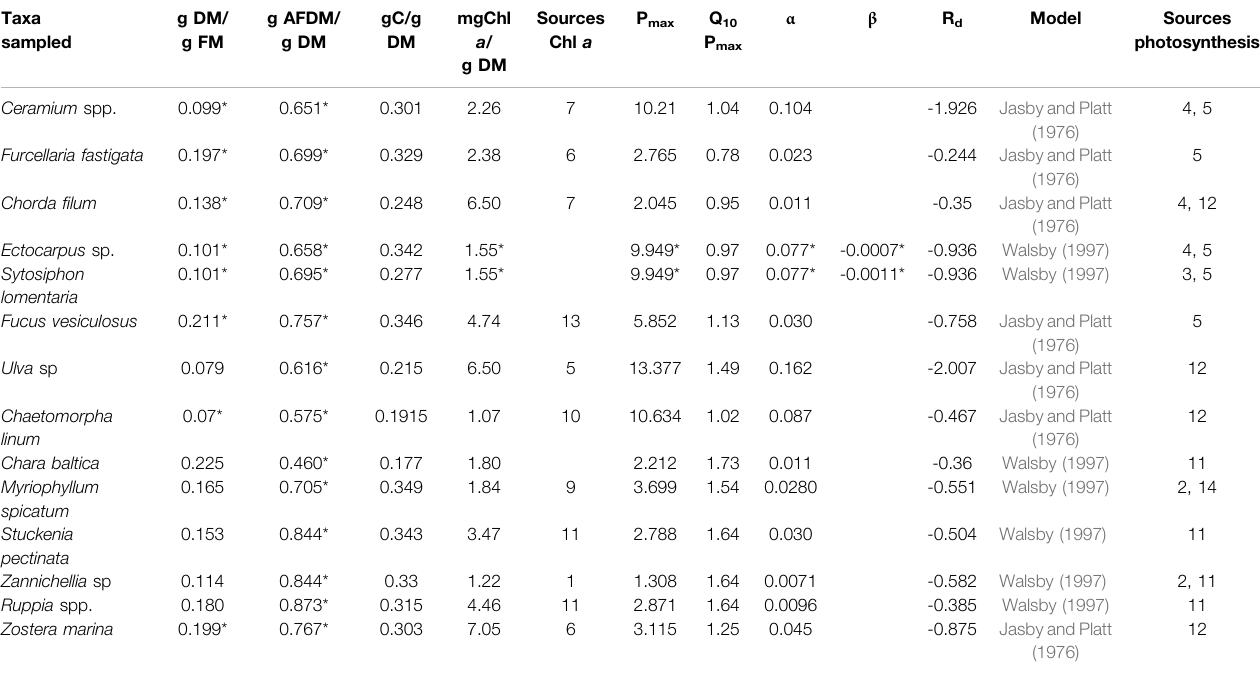
TABLE 2 | Ratios and equations used to calculate biomass and production of the model. Taxa sampled